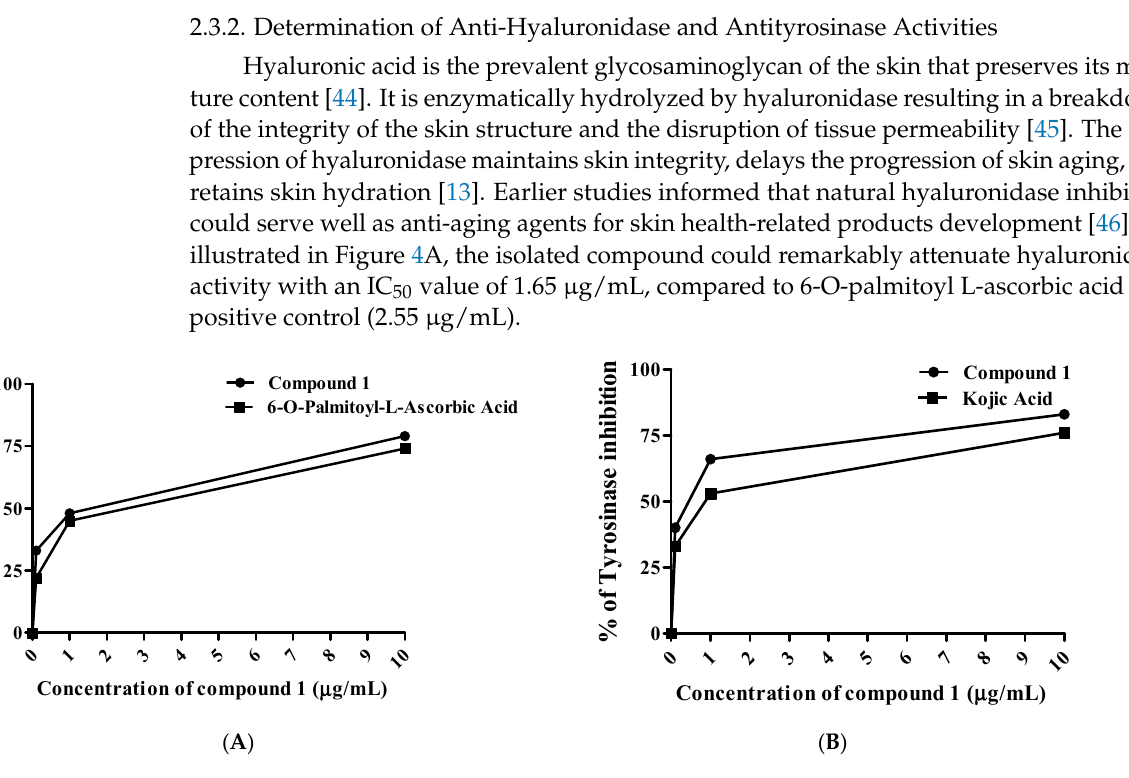
Figure 4. Hyaluronidase ( A ) and tyrosinase ( B ) inhibitory activities of isolated compound. All determinations were carried out in triplicate and the values are expressed as the mean ± SD.